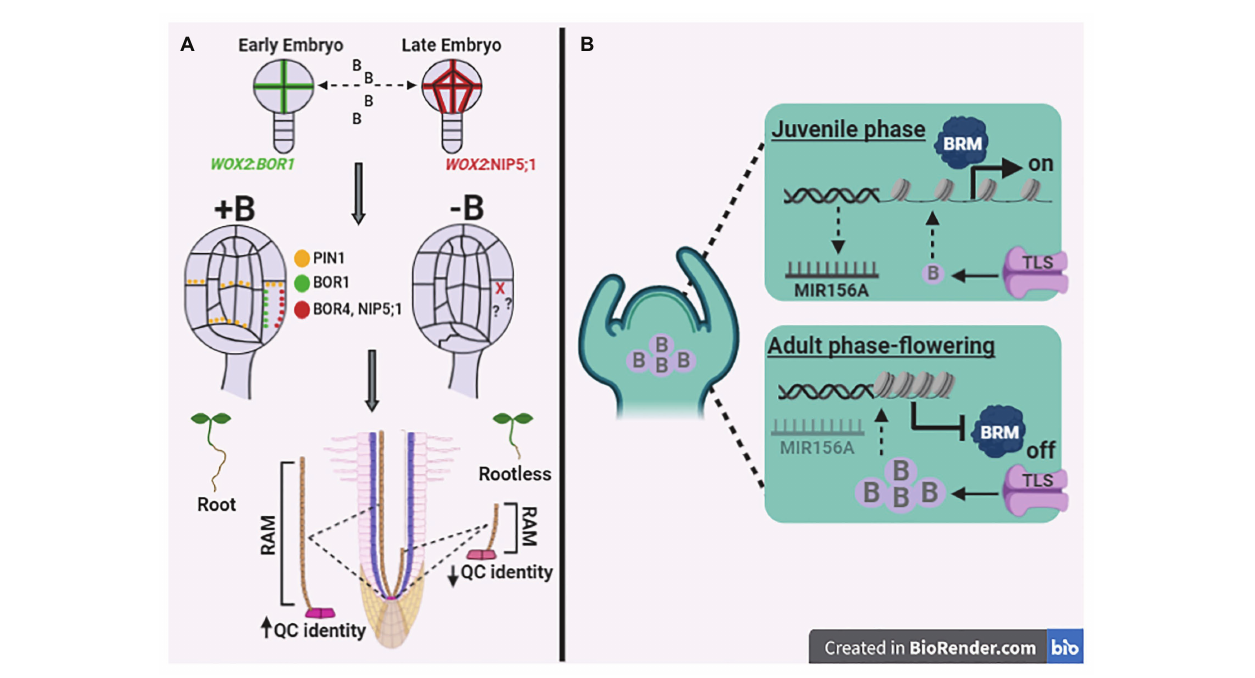
FIGURE 2 | Boron mediating crucial developmental processes in roots and shoots. (A) The asymmetric cell divisions at early embryos exhibit a remarkable pattern related to BOR1, whereas NIP5;1 are the better marker for these divisions on late embryogenesis, suggesting the B role in orientating embryo development. Curiously, the B deficiency induction on mature embryos alters not only BOR1 and NIP5;1 gene expression patterns but also disrupts auxin transport among the different cell-types impairing root apical meristem (RAM) formation, which result in a rootless A. thaliana plants. Furthermore, B deficiency on mature plants reduce length and identity of quiescent center (QC) at RAM, which altogether suggest that B display influence on overall root developmental stages. (B) Shoot apical meristem (SAM) exhibits the B transport differently regulated according with developmental phase, the TRUNCATED LEAF SYNDROME (TLS) transporter remobilize low B levels into SAM at juvenile phase. Apparently, the reduced levels of B enables the activity of Brahma (BRM) chromatin remodeler allowing the expression of miR156A, which arrest the flowering transition in juvenile tissues. The adult phase transition to flowering would be mediated by the increase on B levels at SAM, which would promote blocking of BRM activity, which represses miR156A expression releasing flowering induction. Dotted arrows indicate mechanisms not completely elucidated. Figures were created using the software biorender